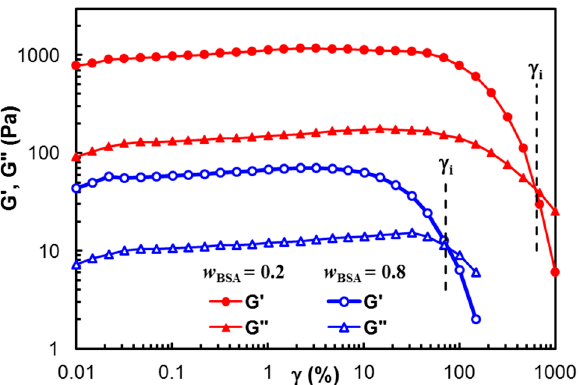
Figure 1. Viscoelastic moduli in amplitude sweep tests for two samples of w BSA = 0.2 and w BSA = 0.8.